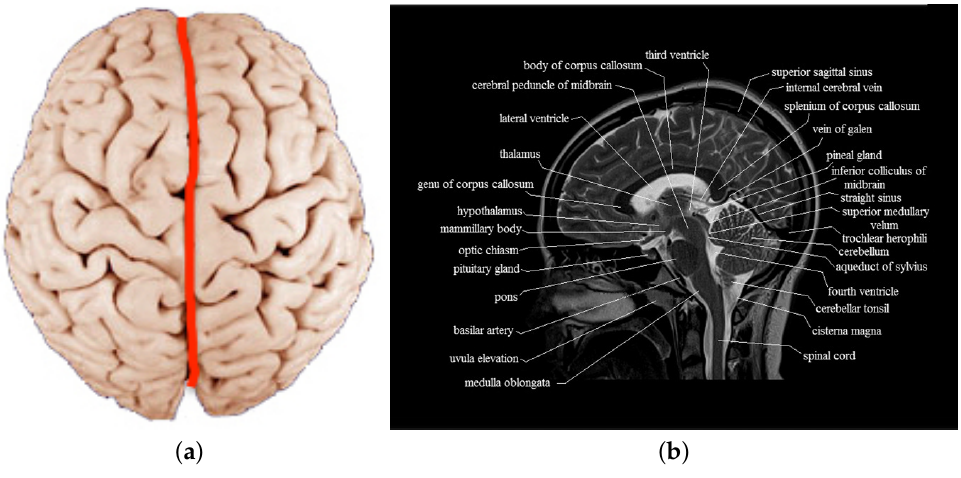
Figure 1. ( a ) inter-hemispheric fissure in a normal human brain; and ( b ) different brain anatomical structures from sagittal cross-section in a magnetic resonance (MR) image (courtesy of [5]). The human brain exhibits an approximately bilateral symmetry across the sagittal